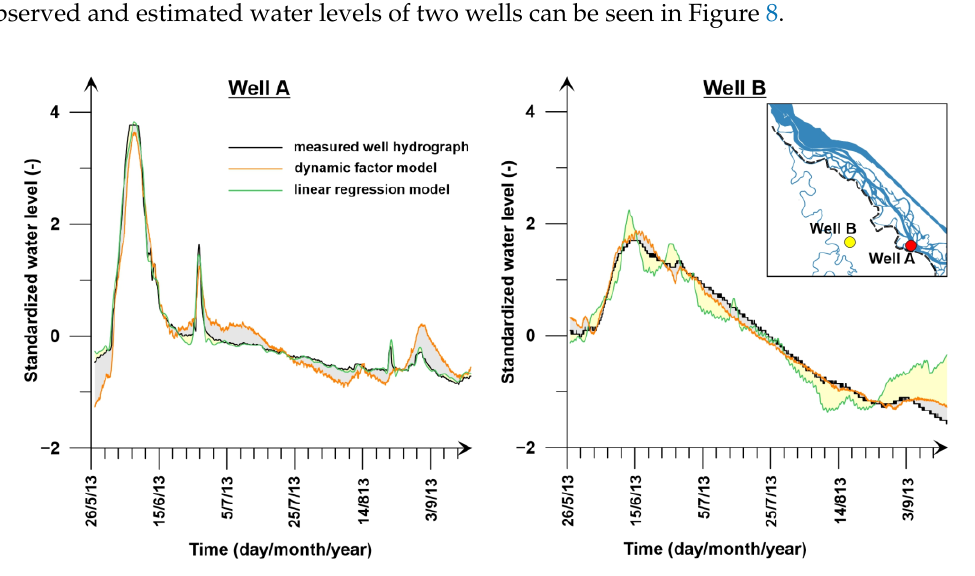
Figure 8. Hydrographs of two wells—“A”, located in the floodplain and “B” on the protected side—with the results of the estimations obtained from different linear models and their difference colored gray and yellow.